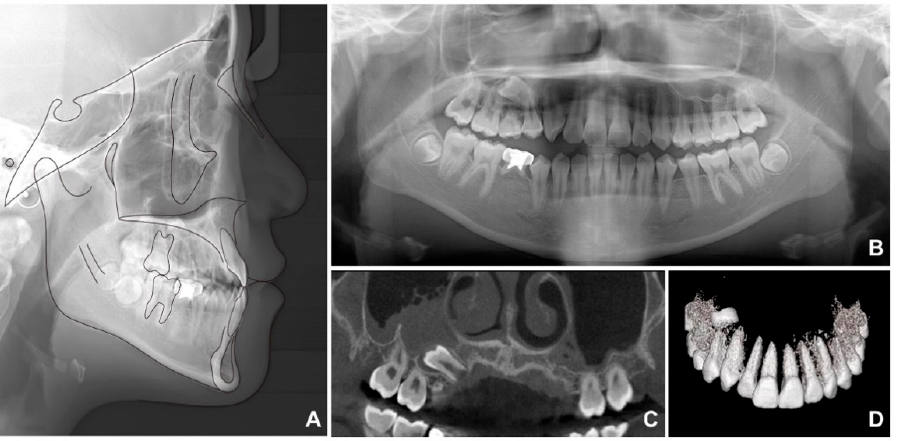
Figure 2. Pretreatment radiographs: ( A ) lateral cephalogram; ( B ) panoramic radiograph; ( C , D ) cone beam computed tomography.